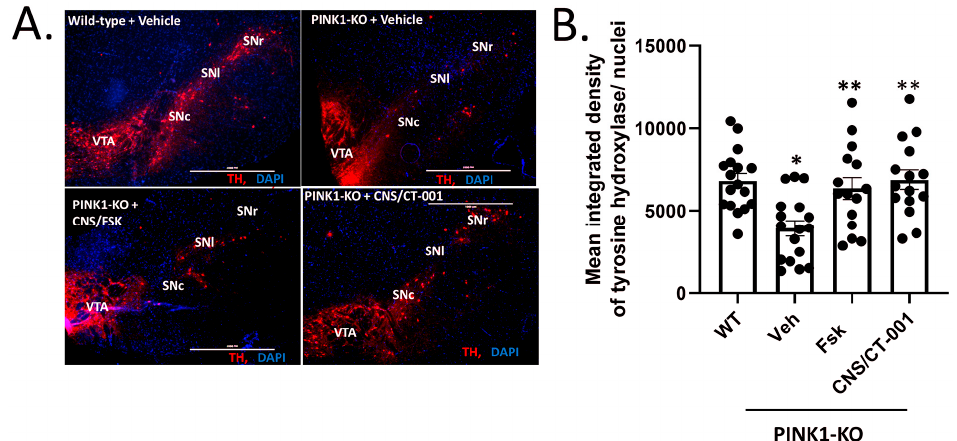
Figure 4. Intranasal delivery of Forskolin or with CNS/CT-001 reverses the loss of SN neurons in symptomatic PINK1-KO rats. ( A ) Representative epifluorescence images of SN slices that were immunolabeled for tyrosine hydroxylase (TH; red channel) to visualize SN dopamine neurons from (a) a 10-month-old WT rat that was intranasally treated with vehicle solution or (b) from 10-month-old PINK1-KO rats that were intranasally treated with vehicle solution, or (c) intranasally treated with Forskolin, or (d) intranasally treated with CNS/CT-001. ( B ) Compiled quantification of the mean fluorescence intensity of TH (red channel) in midbrain slices for the indicated treatment conditions (Veh, FSK, CNS/CT-001). Please note that the mean integrated density for the TH-immunostained ROIs within the SN was quantified using Image J and normalized to the number of nuclei labeled with DAPI (blue channel). Mean ± SEM. *: p ≤ 0.05, Kruskal-Wallis test with Bonferroni correction, n = 14–18 rats per group, *: p < 0.05 vs. WT; **: p < 0.05 vs. PINK1-KO/Veh. Legends: SNC: substantia nigra pars compacta, SNR: substantia nigra pars reticulata, SNL: substantia nigra pars lateralis. Scale bar: 100 µ m. DAPI Blue; TH Red. Each circle indicates an individual animal plotted in the graph.